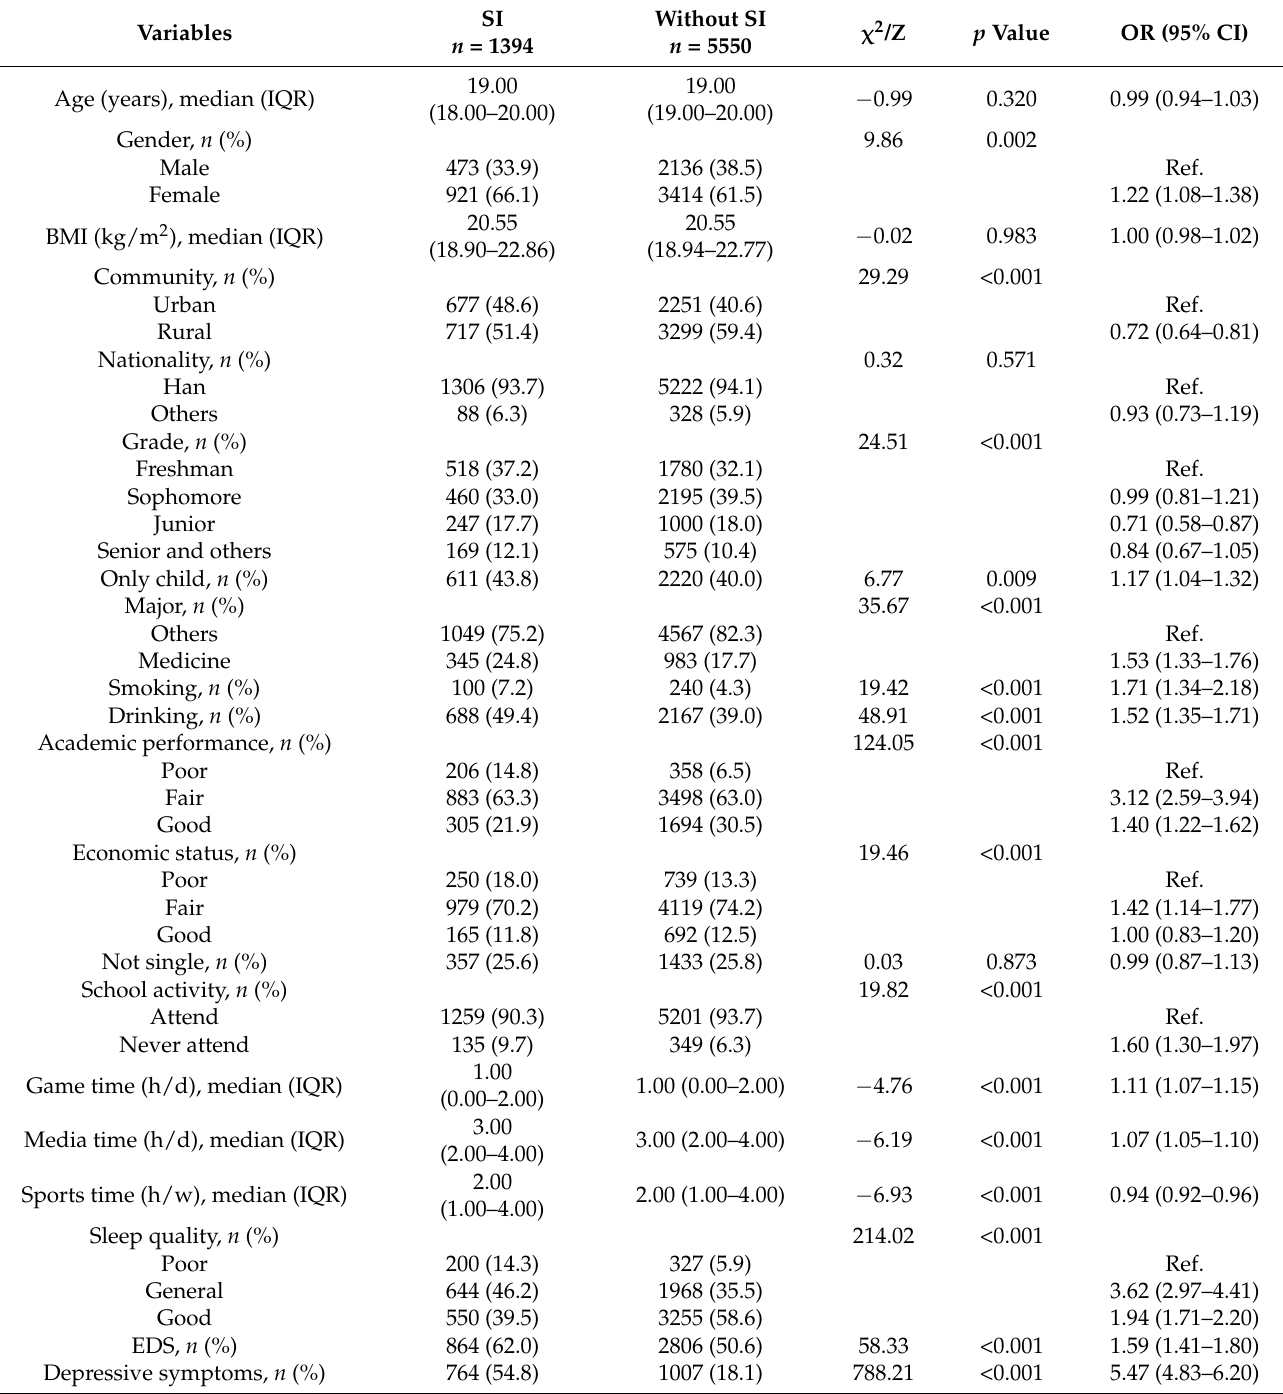
Table 1. Demographics and clinical characteristics between participants with and without suicidal ideation ( n =